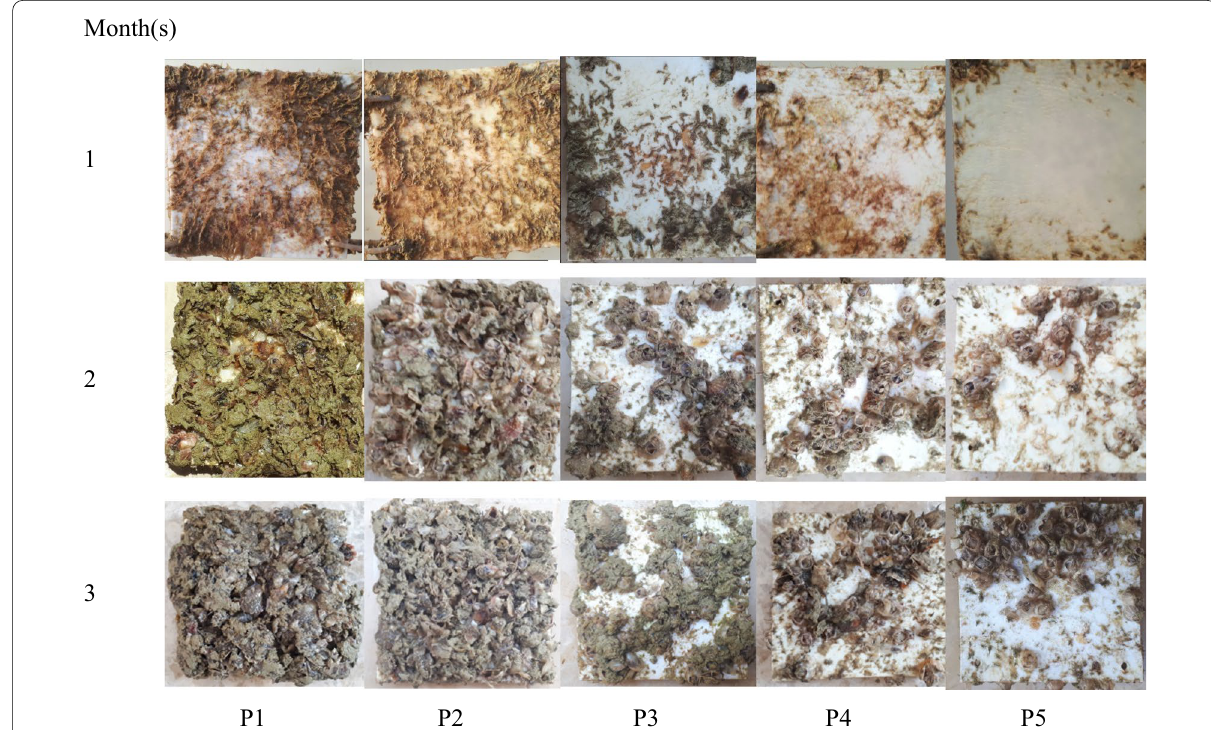
Fig. 2 Panels after immersion in the seawater for three months. P1: uncoated panel (control); P2: panel coated with PCL (100%); P3: panel coated with PCL 100% / antifoulant 10 phr; P4: panel coated with PCL 90% /PLA 10% / antifoulant 10 phr; P5: panel coated with PCL 80% /PLA 20% / antifoulant 10